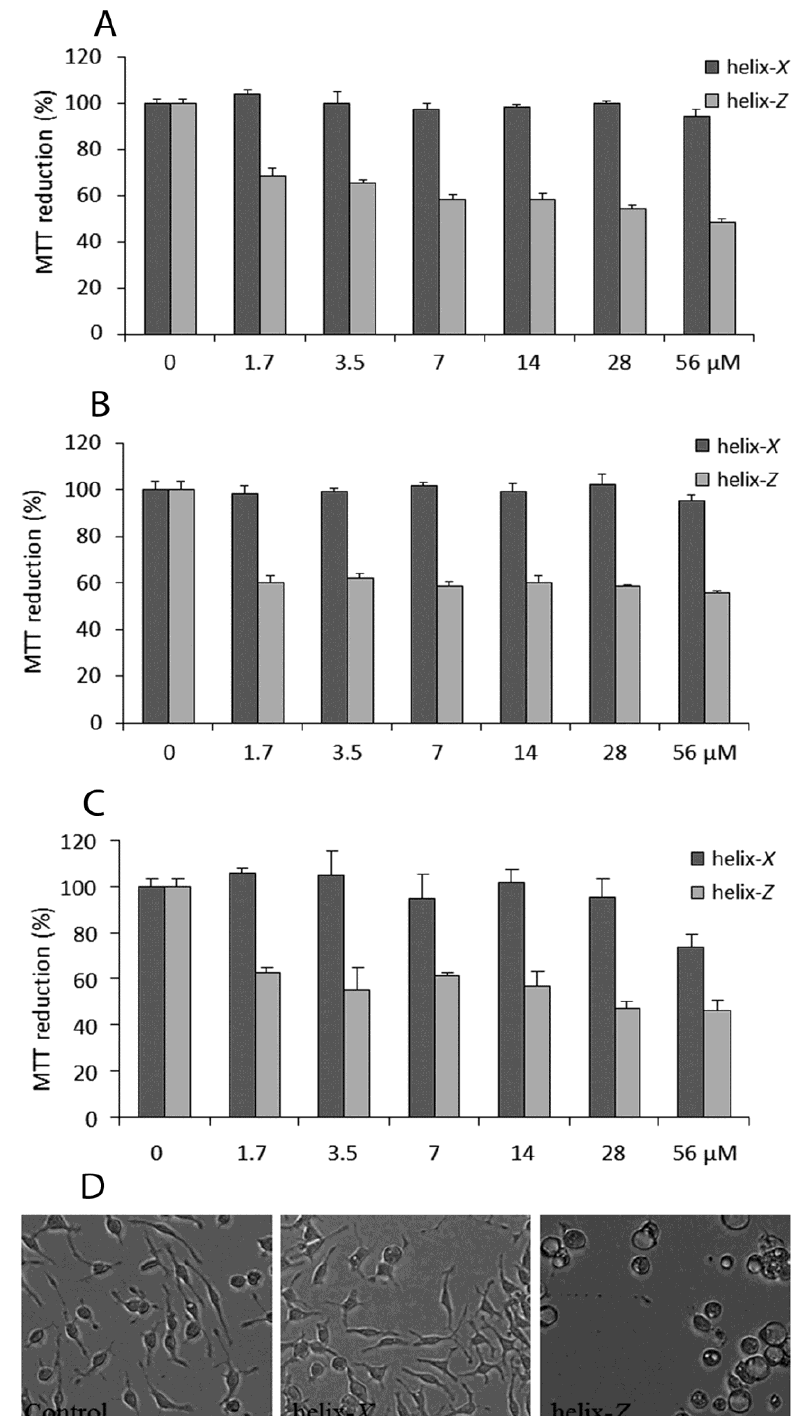
Figure 6. Cytotoxic effects in microglia associated with the exposure of helix- X and helix- Z . ( A ) Cell viability determined by MTT for cells treated with peptide previously incubated 0.5 h at 37 °C; ( B ) Cells treated with peptide previously incubated 6 h at 37 °C; ( C ) Cells treated with peptide previously incubated 120 h at 37 °C; ( D ) Light microscopy showing microglia treated with both peptides (56 µM) previously incubated 120 h at 37